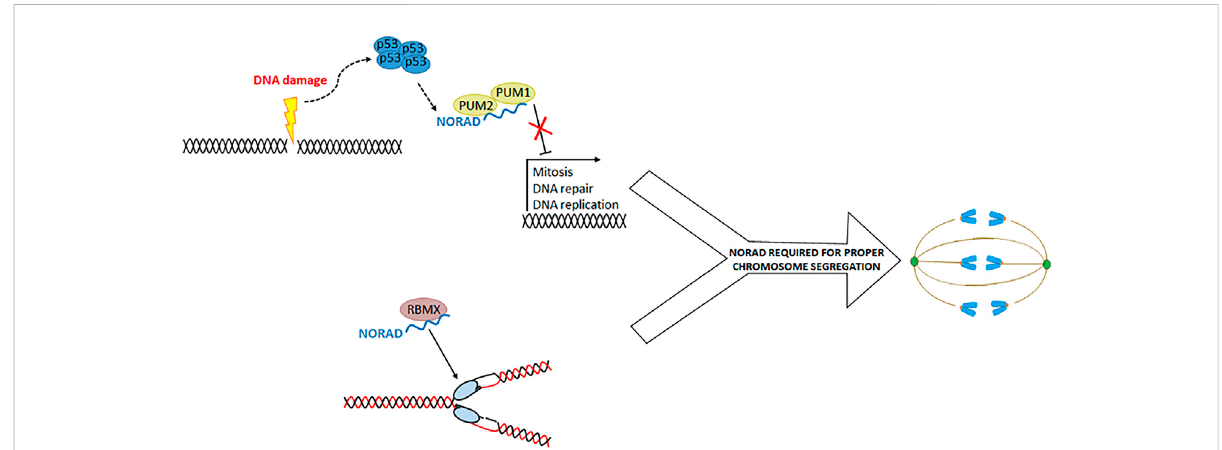
FIGURE 1 NORAD is involved in the proper segregation of chromosomes. Two mechanisms by which NORAD promotes chromosome segregation have been proposed. First (above), NORAD negatively regulates PUM1 and PUM2 proteins allowing the expression of genes involved in cell cycle processes. On the other hand, NORAD forms a ribonucleoprotein complex with the RBMX protein, where they have a role in DNA duplication and repair. However, it is not clear how this function participates in chromosome